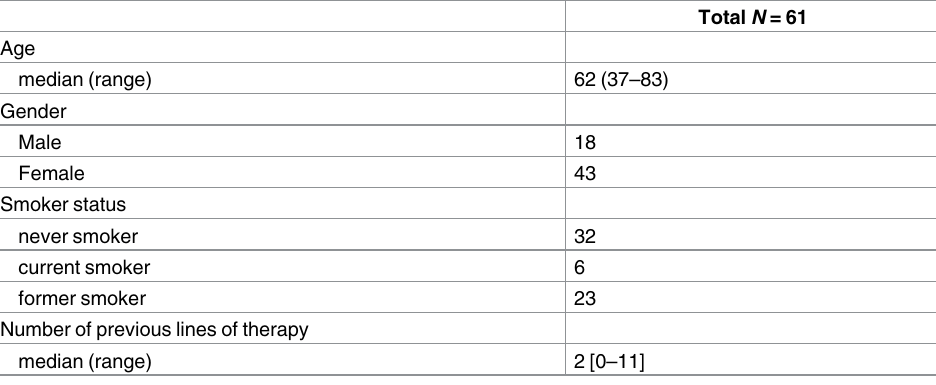
Table 1. Patient characteristics.